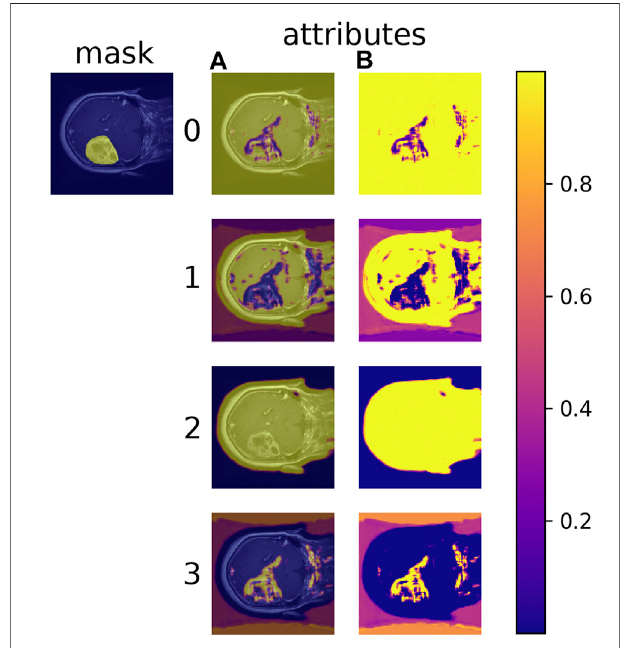
FIGURE 10 | The MAC-CNN ’ s M (cid:2) 4 attributes applied in a sliding- window manner across a single brain scan. Each row represents a different attribute being evaluated, with the raw output (B) and the output overlaid on the image (A) . A higher value means the given attribute is expressed more strongly at that location in the image. Each attribute picks up different aspects of the scan, and different attributes can either positively or negatively exhibitaspectsofdifferentmaterialcategories.Forexample,attributes0and1 negatively correlate to the expertly annotated mask (tumor) while attribute 3 correlates highly to